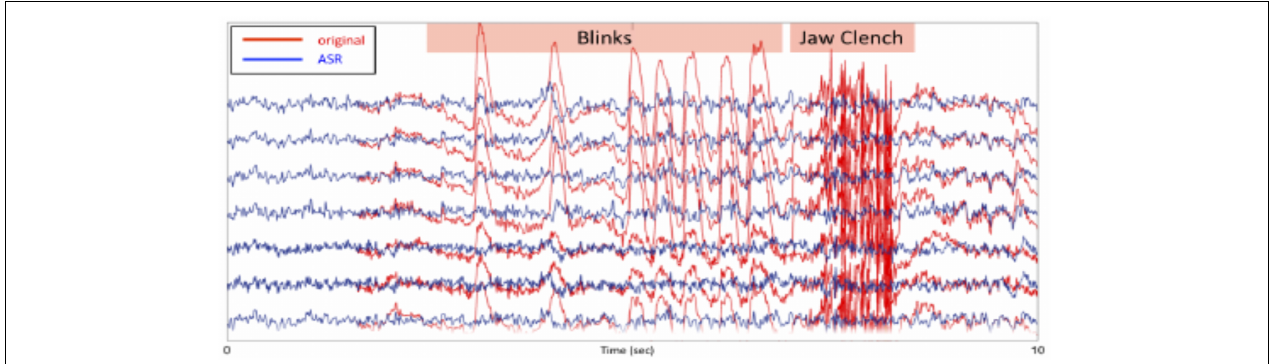
FIGURE 3 | For artifact rejection, each day an initial EEG baseline was measured for 1 min (start baseline), followed by six training blocks of 5 min each (block 1–6). This initial baseline was used by the ASR artifact rejection algorithm in order to optimize the filtering all feedback sessions for the day using the asr_calibrate function (default parameters of the ASR algorithm were used; variance rejection cut off of 5; block size of 10 sample to calculate covariance matrix; window size of 500 ms and window overlap of 330 ms.